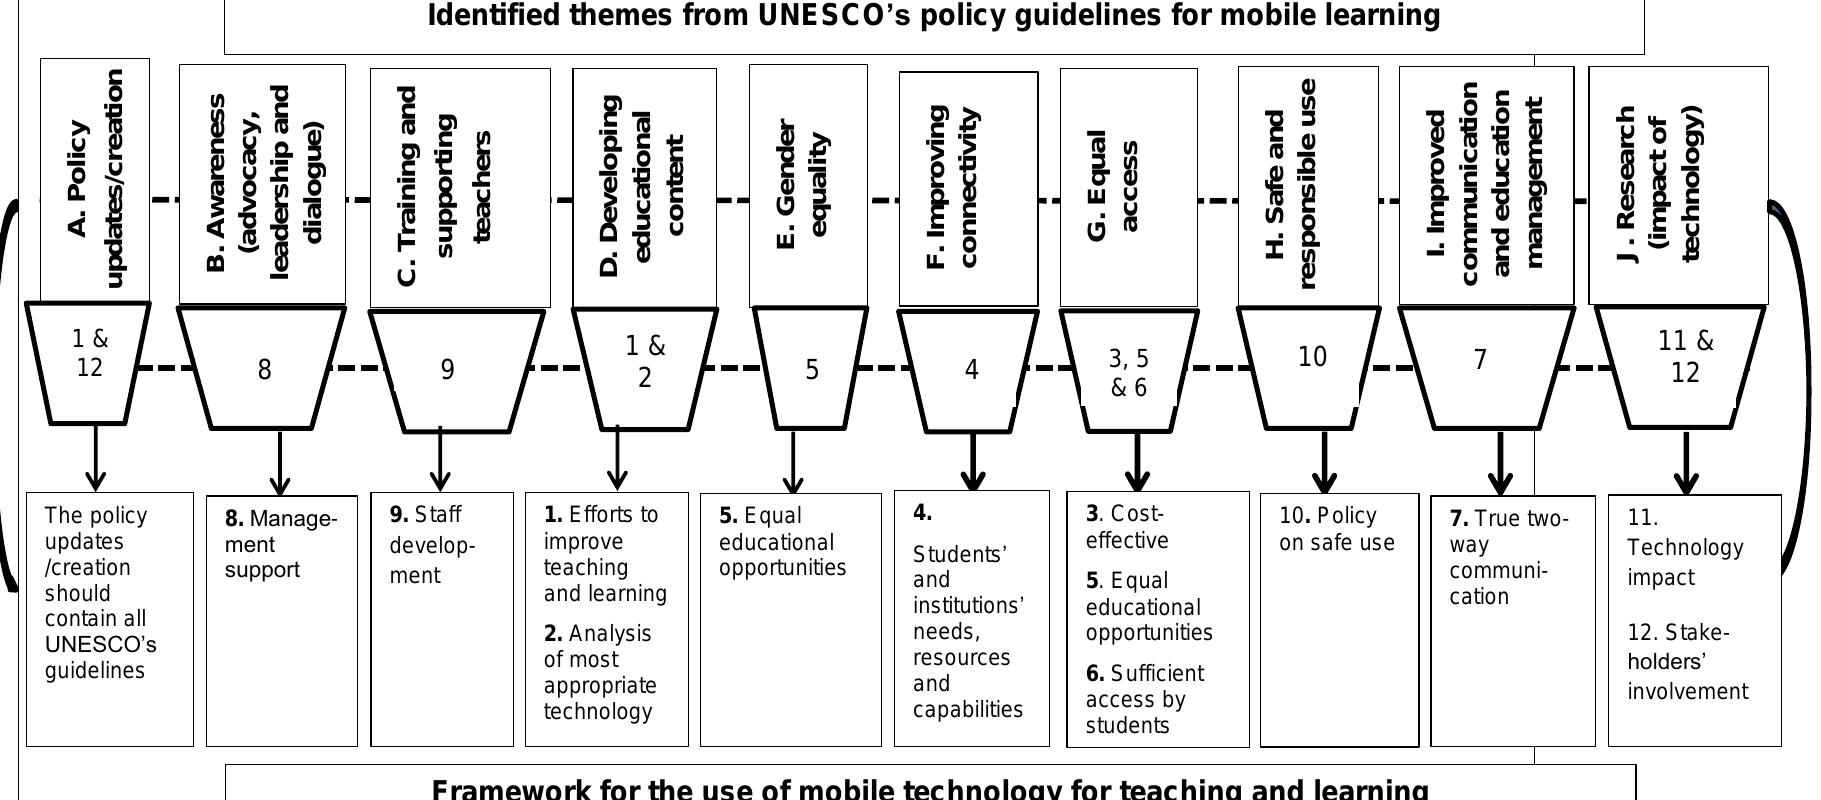
Figure 4. Integration between identified themes from UNESCO’s policy guidelines and framework for the use of mobile technology for teaching and learning